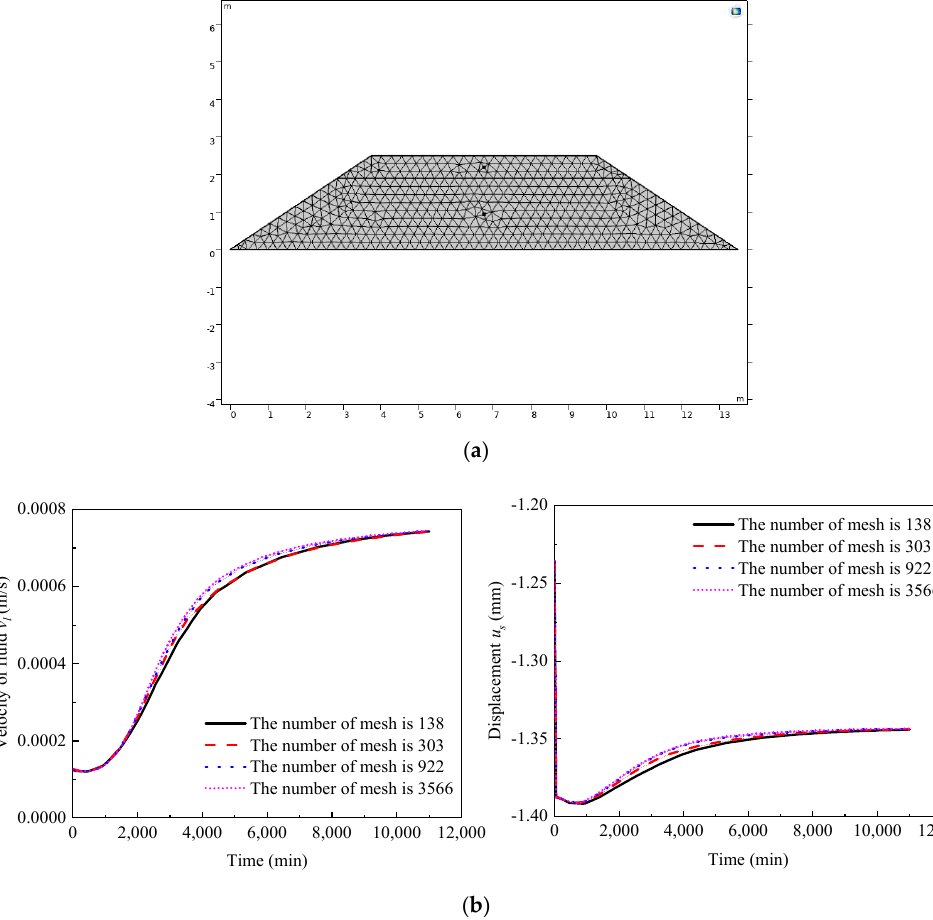
Figure 9. ( a ) Meshing for the model; ( b ) the influence of mesh number.